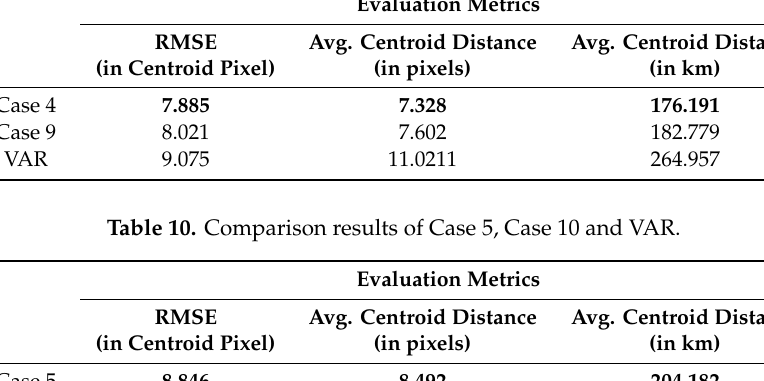
Table 9. Comparison results of Case 4, Case 9 and VAR.